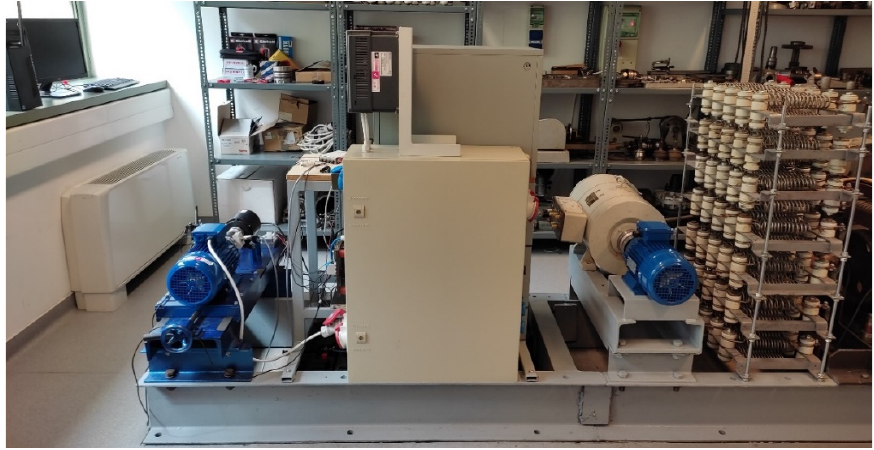
Figure 1. Photo of the measurement system.